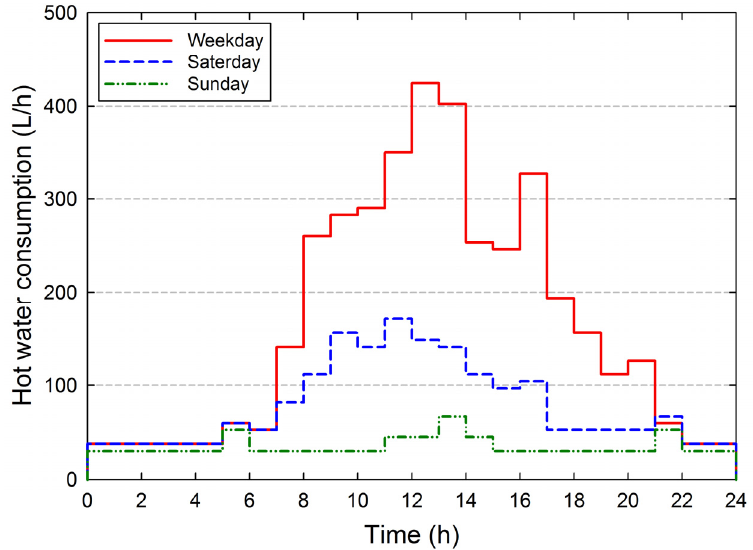
Figure 2. Hourly hot water consumptions over one day in a case study building.